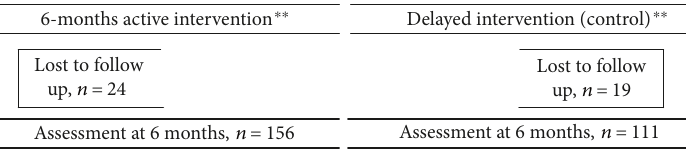
Figure 1: Screening and recruitment. ∗ See text for assessment details. ∗∗ See text for methodology of